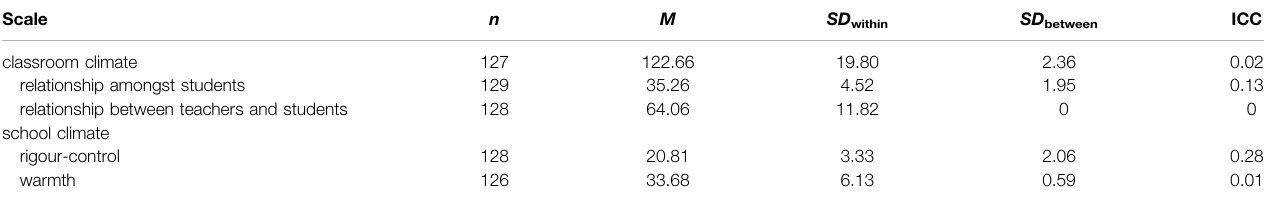
TABLE 2 | ICC, means and standard deviations of the outcome measures. Scale n M SD